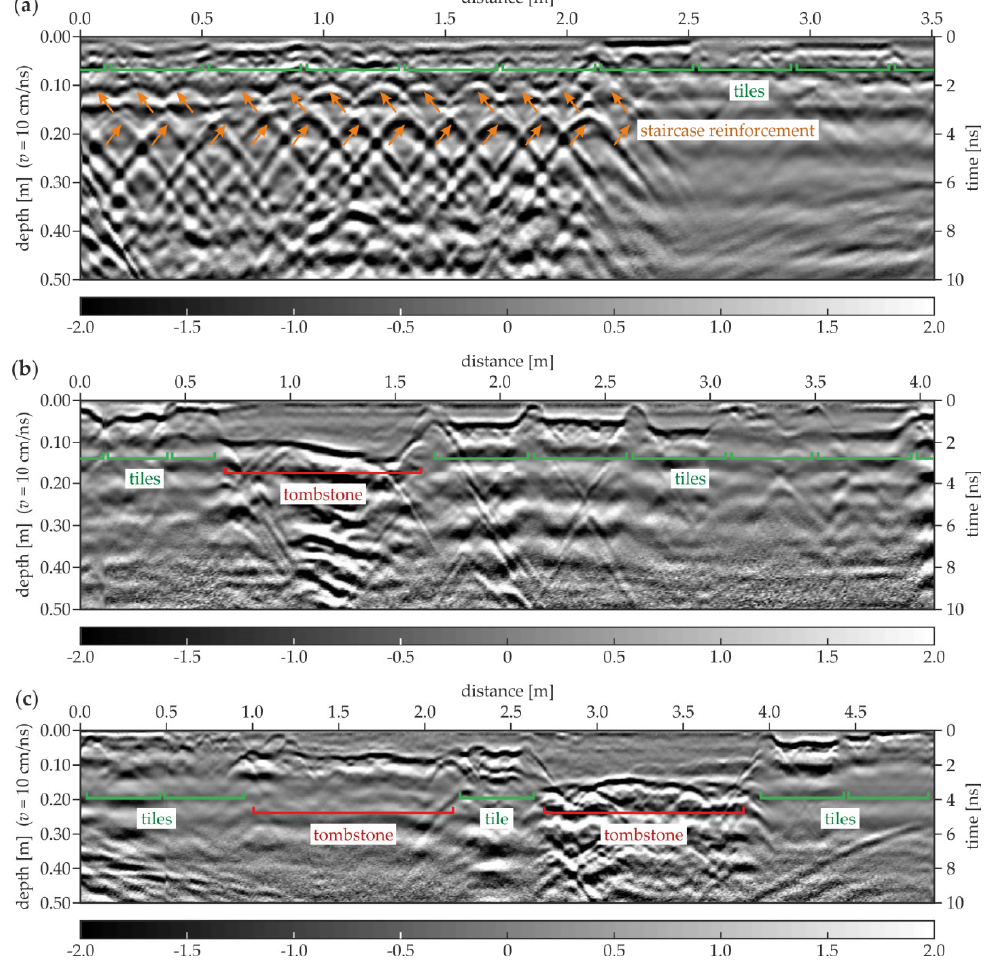
Figure 20. GPR B ‐ scans for the north aisle (survey B): ( a ) B ‐ 5; ( b ) B ‐ 35; ( c ) B ‐